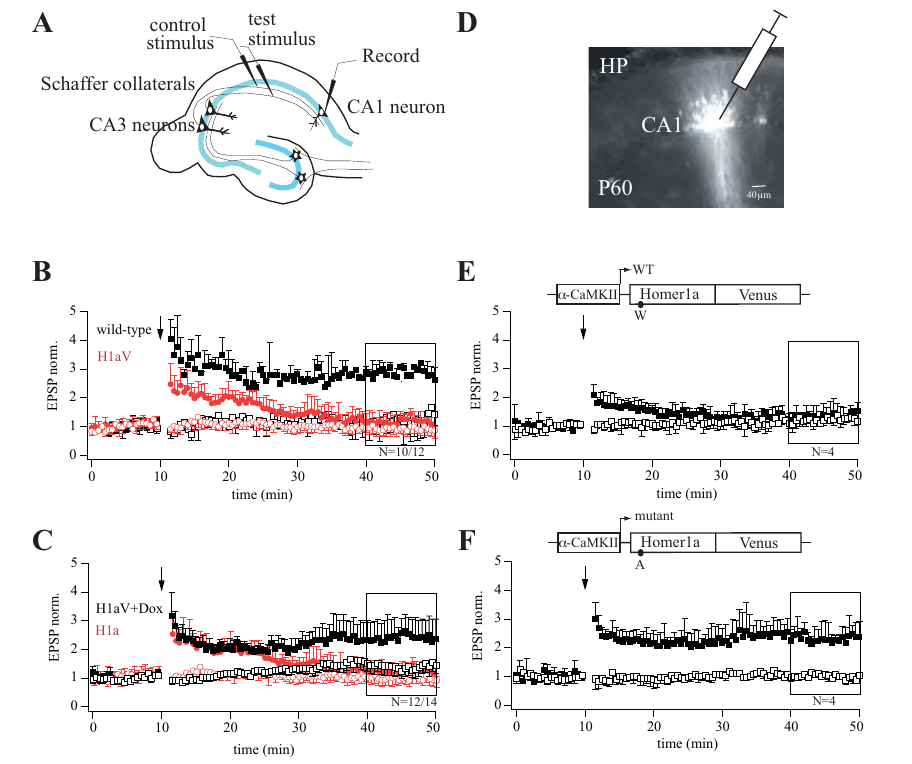
Figure 2. LTP profiles during sustained H1aV expression in CA1 pyramidal neurons . ( A ) Diagram of the experimental setup for cellular LTP recordings. ( B ) Theta-burst pairing (TBP) induced LTP in hippocampal CA3-CA1 synapses of wild-type and TgH1aV.Fb mice. In wild-type mice, three TBP trains resulted in LTP in the paired pathway. TBP in slices from TgH1aV.Fb mice resulted in a transient potentiation of synaptic responses, lasting up to 30minutes postpairing (red circles). TgH1aV.Fb mice completely lack the late component of TBP-induced potentiation found in wild-type mice (black squares). ( C ) The same protocol was applied to TgH1aV.Fb mice given dox in the drinking water from P21 until P42. Dox-treated mice (black traces), when compared to untreated ones (red traces), showed robust LTP (black squares), indicating rescue from sustained H1aV overexpression. ( D ) Fluorescent cells in hippocampal CA1 region 18 days after stereotaxic injection of lentivirus expressing either wild-type or mutant rat H1aV. LTP induced in hippocampal CA3-CA1 synapses of mice injected with lentivirus expressing H1aV ( E ) resulted in a transient potentiation of synaptic responses, whereas H1aV(W234A) expression showed normal LTP of the paired pathway ( F ). Schematic drawing of the lentiviral vectors illustrates LTP profiles after α -CaMKII promoter-dependent transcription of wild-type ( E ) and mutant ( F ) H1aV. The amino acid substitution in the Homer1a EVH1 domain is indicated below the expression cassette for Homer1a.